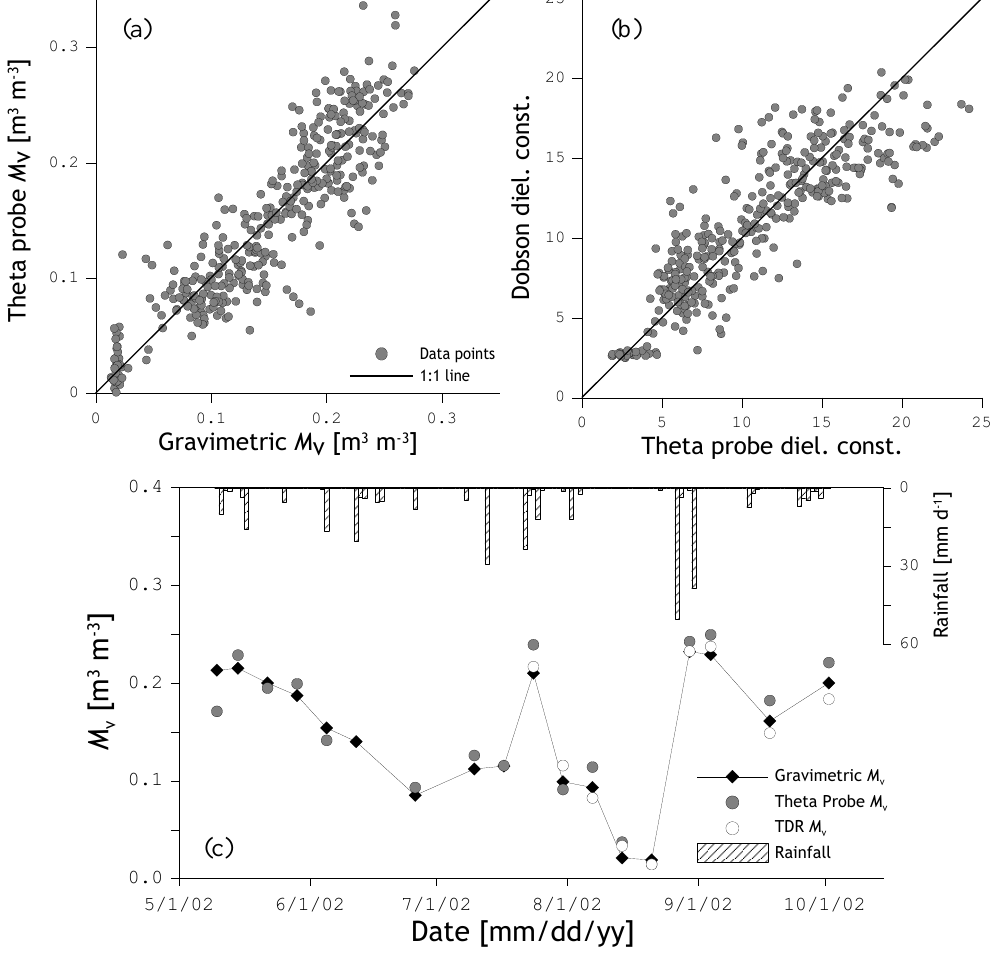
against the calculations made using the r measured by the theta probe, TDR and gravimetric v